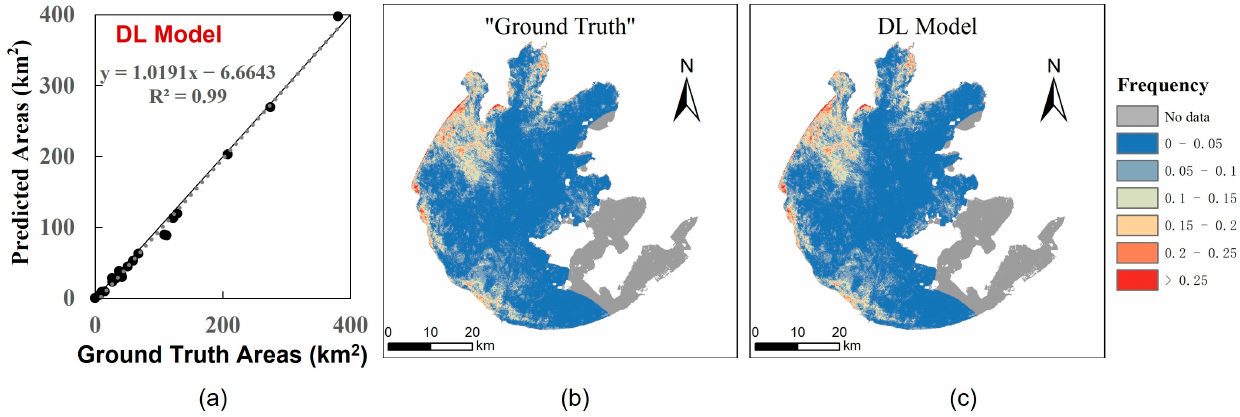
Figure 13. ( a ) Scatter plot of surface value area and predicted result area of CyanoHABs in Taihu Lake; ( b ) Outbreak frequency map of CyanoHABs in Taihu Lake by “ground truth” data; ( c ) Outbreak frequency map of CyanoHABs by predicted results by the U-Net